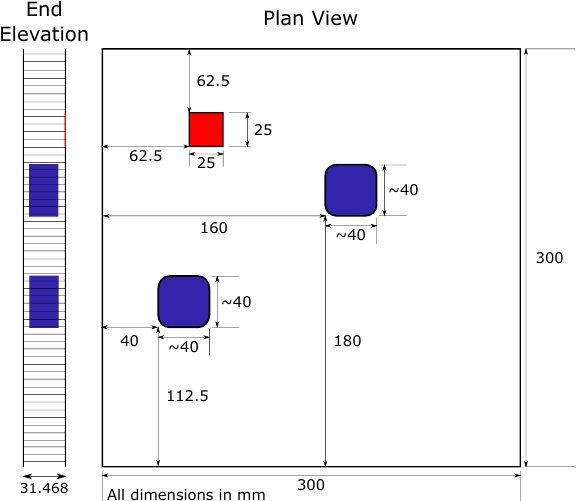
Figure 2. Panel D1 defect locations. Delamination in red, impact damage